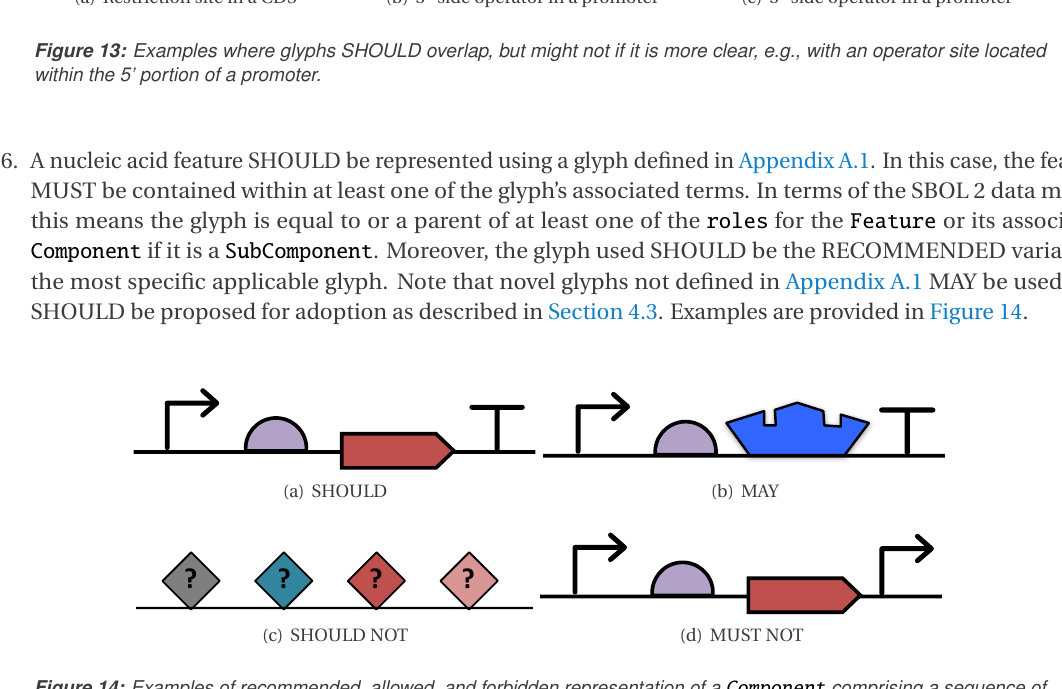
Figure 14: Examples of recommended, allowed, and forbidden representation of a Component comprising a sequence of promoter, ribosome entry site, CDS, and terminator: (a) is RECOMMENDED because it uses the preferred variant of the most specific defined glyphs, (b) is allowed because it uses some novel custom non-conflicting symbol, not matching any glyph defined in this document, to encode more specific information about the particular CDS, (c) is recommended against because it uses less specific glyphs, and (d) is forbidden because it use a promoter symbol to represent the terminator.